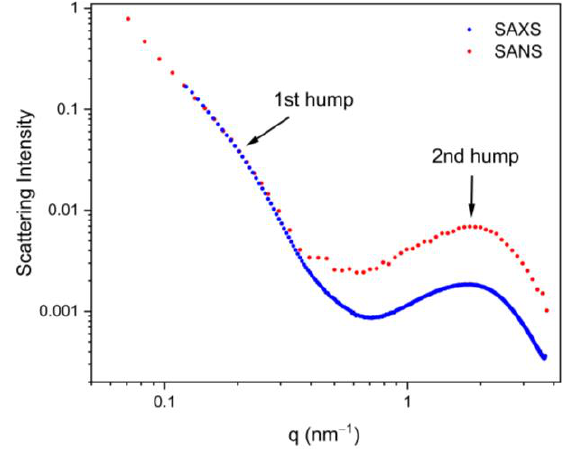
Figure 2. Representative SAXS (blue) and SANS (red) curves of a homogenized and water quenched sample. The SAXS curve was multiplied with a constant factor, such that the curves overlapped at low/intermediate q .